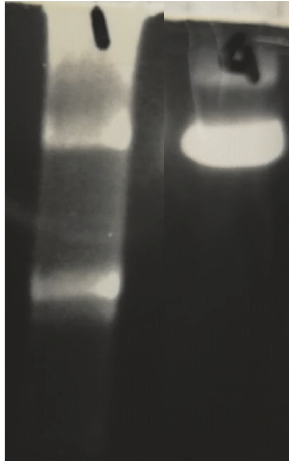
Figure 2: Long-PCR analysis of mitochondrial DNA in muscle tissue: on the left, the test performed on our patient, which shows multiple deletions of mtDNA, and, on the right, a normal